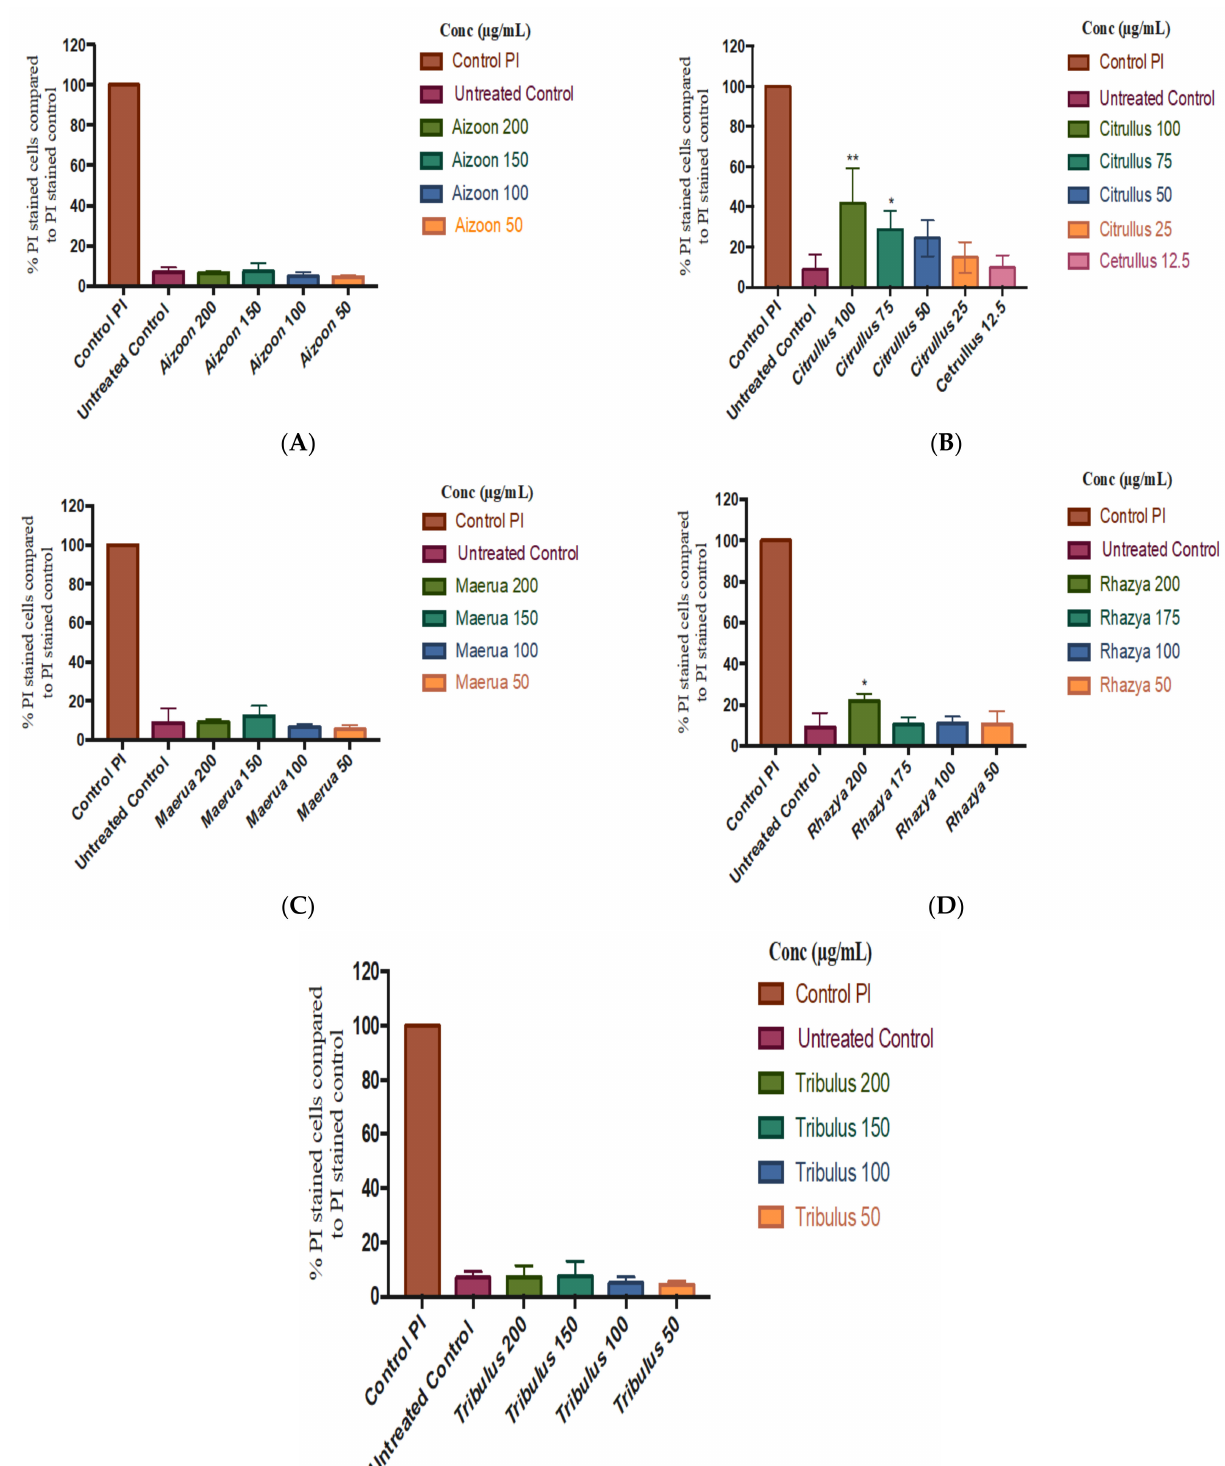
Figure 2. Percentage of HaCaT cells stained with PI for the plant extracts at different concentrations compared to PI control (mean ± S.D.): ( A ) Aizoon canariense , ( B ) Citrullus colocynthis , ( C ) Maerua crassifolia , ( D ) Rhazya stricta , and ( E ) Tribulus macropterus . The results were obtained through three independent experiments. Statistical analysis of significant changes in the treated cells versus the untreated controls (* p < 0.05, ** p <